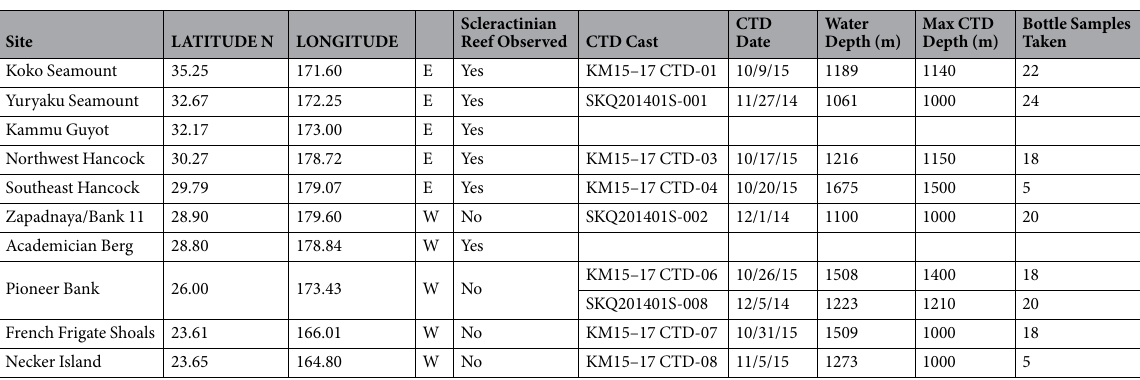
Table 1. Locations surveyed as a part of this study. All sites were surveyed at depths of 200–700 m along contours at 50 m depth intervals inclusive. Sites from Academician and southeast are part of the pre-2016 expansion boundaries of the Papahānaumokuākea Marine National